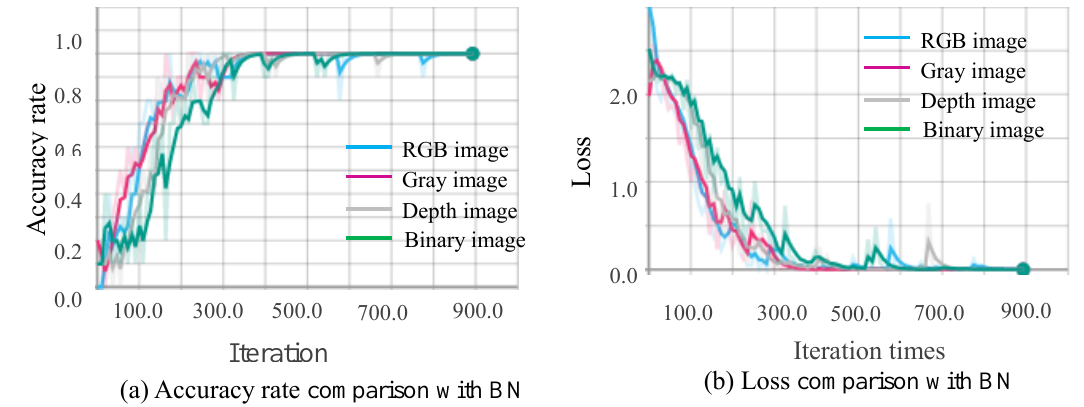
Figure 14. Comparison of training for four data sets.